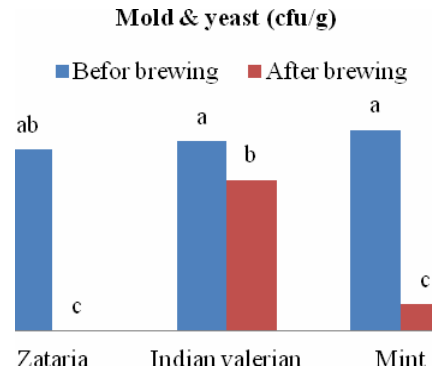
Fig. 5. Mean comparison of mould and yeast in brewing